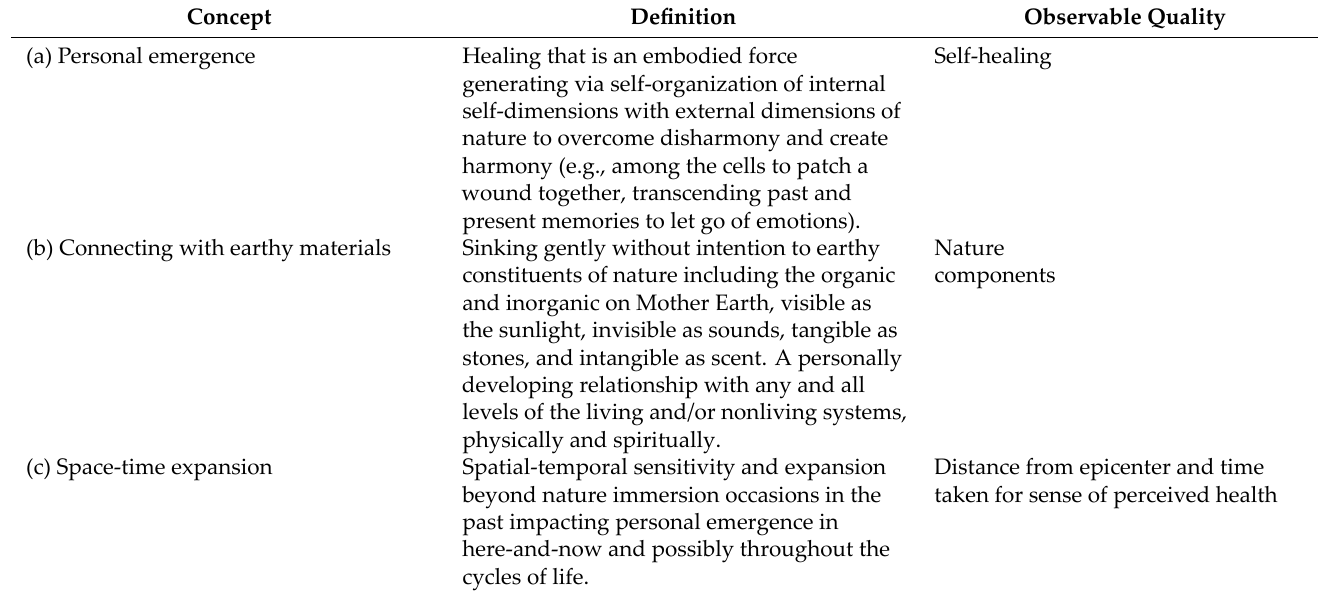
Table 1. A summary of three core concepts in the nature immersion model [1] (pp. 388–389),